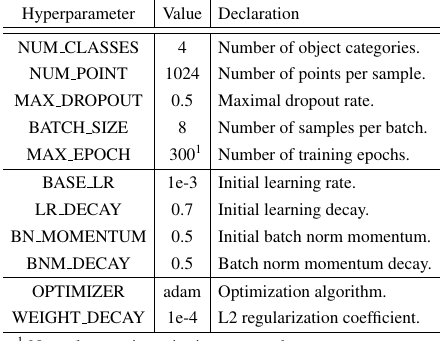
Table 3. Hyperparameters and default / optimized values for PointNet++.